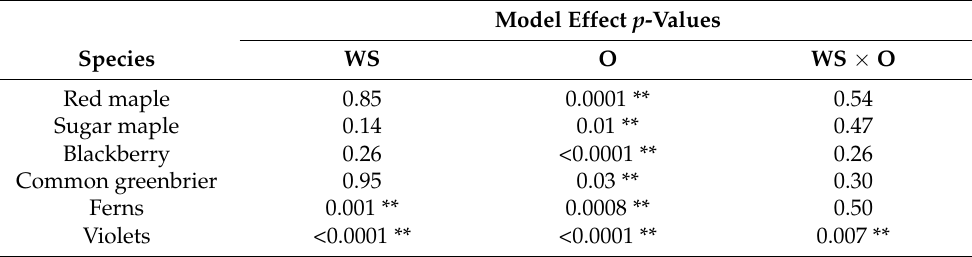
Table 4. p -Values from ANOVA testing the effects of Watershed (WS; fertilized WS3 vs. unfertilized WS7), Organ (O; root vs. foliage), and their interaction (WS × O) on root and foliar NRA of individual overstory maple species and four common herb-layer species at the Fernow Experimental Forest, Parsons, WV,